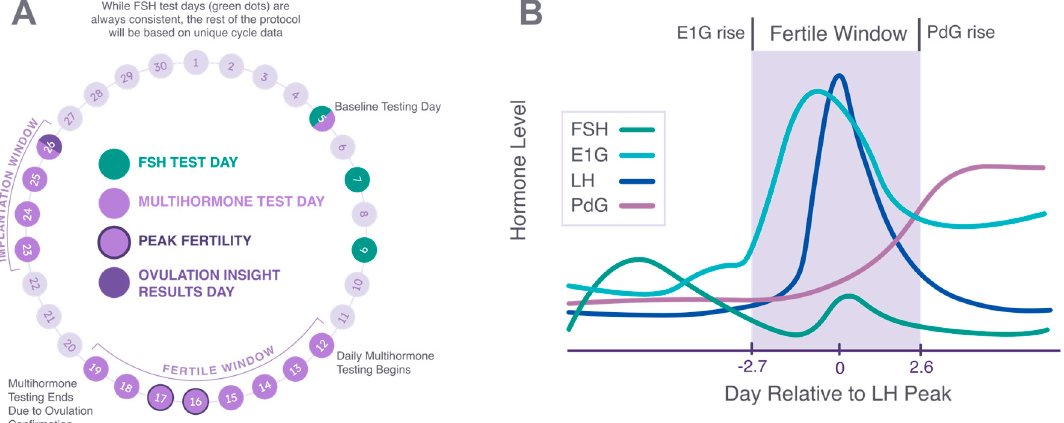
Figure 2. Proov Complete successfully directs testing to find up to 6 fertile days and confirm ovulation. ( A ) The Proov Insight App directs testing. FSH testing is always on days 5, 7, and 9, and fertile window testing begins according to an individual’s unique cycle data. Ovulation confirmation by PdG rise ends fertile window testing, and peak fertility based on LH surge then determines timing of implantation window PdG testing. On the final day of testing, an Insight Report is generated (see Figure 3). ( B ) Complete finds up to 6 fertile days (average of 5.32) based on E1G rise opening the fertile window and PdG rise closing the fertile window.